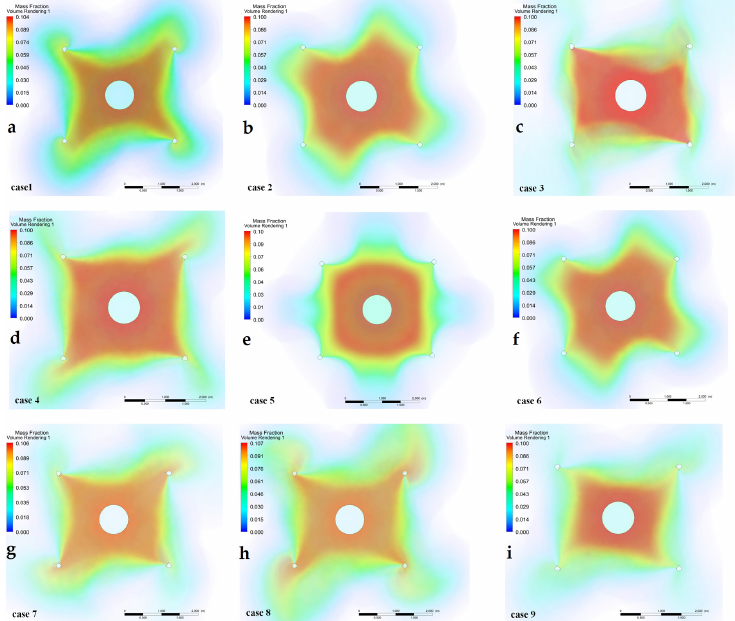
Figure 14. The pollutants’ mass fraction under various air curtain parameters: ( a ) case 1 (blow and suction; 20 mm; 5 m/s; 0.8 m/s); ( b ) case 2 (blow and suction; 10 mm; 5 m/s; 0.8 m/s); ( c ) case 3 (blow and suction; 40 mm; 5 m/s; 0.8 m/s); ( d ) case 4 (unilateral blowing; 20 mm; 5 m/s; 0.8 m/s); ( e ) case 5 (bilateral blowing; 20 mm; 5 m/s; 0.8 m/s); ( f ) case 6 (blow and suction; 20 mm; 3.5 m/s; 0.8 m/s); ( g ) case 7 (blow and suction; 20 mm; 6.5 m/s; 0.8 m/s); ( h ) case 8 (blow and suction; 20 mm; 5 m/s; 1.1 m/s); ( i ) case 9 (blow and suction; 20 mm; 5 m/s; 0.5 m/s). 5.2. The Variation in the Mass Fraction of Pollutants in the Horizontal Direction In order to quantify the performance of air curtains in limiting pollutants, the length of the air curtain jet was set as 2.5 m, and the distance between the air curtain and the cylindrical axis was set as 1.5 m, and the concentration of pollutants was varied with the horizontal distance from the cylindrical axis, as shown in Figure 12, and the non-air cur- tain jet was taken as the reference, compared with the air curtain barrier performance of different jet widths (10 mm, 20 mm, 40 mm), different air curtain jet modes (blow and suction, unilateral blowing, bilateral blowing) and different jet velocities (3.5 m/s, 5.0 m/s, 6.5 m/s). In addition, the effects of different induced wind velocities (0.5 m/s, 0.8 m/s, 1.1 m/s) on the air curtain barrier performance were compared, and the device’s applicability was verified. Figure 15a, which depicts the horizontal variations in pollutants with different jet widths (10 mm, 20 mm, 40 mm) and the non-air curtain jet, reveals that the rapid decline in the pollutant mass fraction mainly occurred at 1.4~2.0 m. Compared with the non-air curtain jet, when the air curtain jet width was 10 mm, the mass fraction of pollutants out- side the air curtain did not decrease significantly, which indicates that the air curtain with